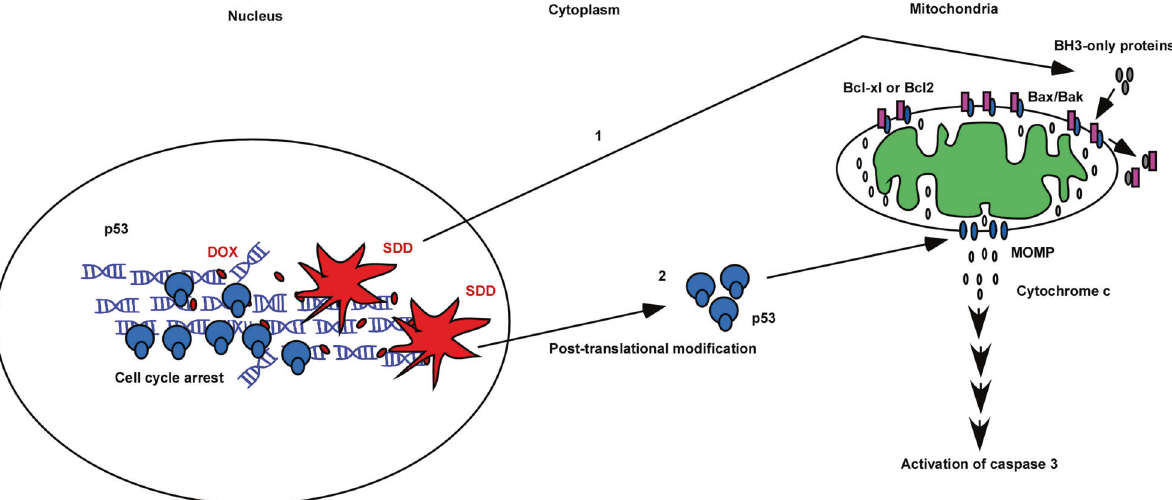
Fig. 1 SDD activated BH3-only proteins (Bim) and p53 proteins to work as sensitizers and activators, respectively, through the dual control mode for MOMP. Bim action was in p53-independent manner and the transcriptional activity of p53 did not involve in SDD-induced apoptosis. Cell death increased in over-expressed p53 condition and the substantial amounts of p53 localized in cytosol during apoptosis in prostate cancer. Based on these results, we initially proposed that p53 proteins in cytosol might work as activators in SDD-induced apoptosis. However, the role of p53 proteins as activators was not supported by the results from the studies of glioblastoma and osteosarcoma. Thus, we thought that cell death caused by p53 overexpression condition might not account for the real physiological role of p53 in apoptosis and p53 might not be an activator in the dual control